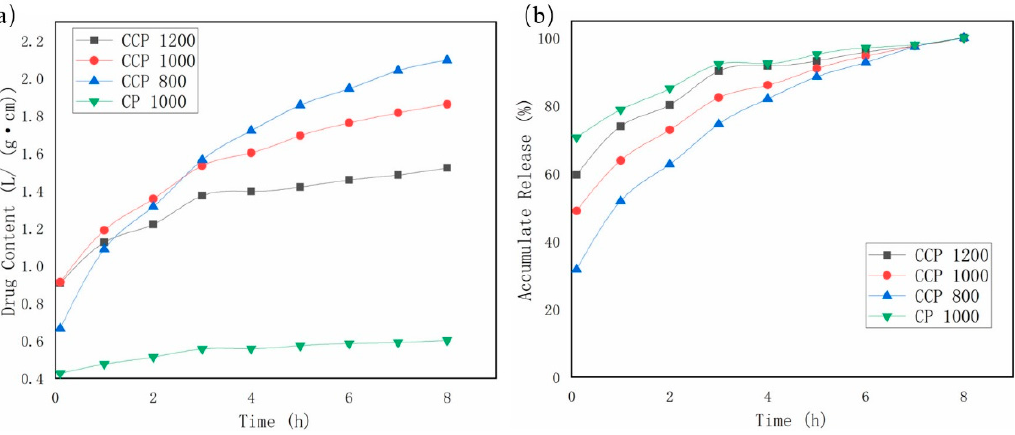
Figure 7. ( a ) Drug release curve of printed scaffolds; ( b ) drug accumulation curve of printed scaf-